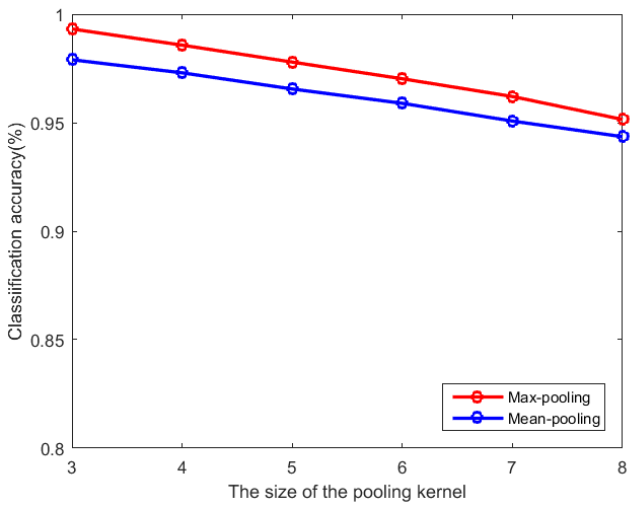
Figure 9. Effects of the Pooling Kernel Size on the Classification Accuracy.